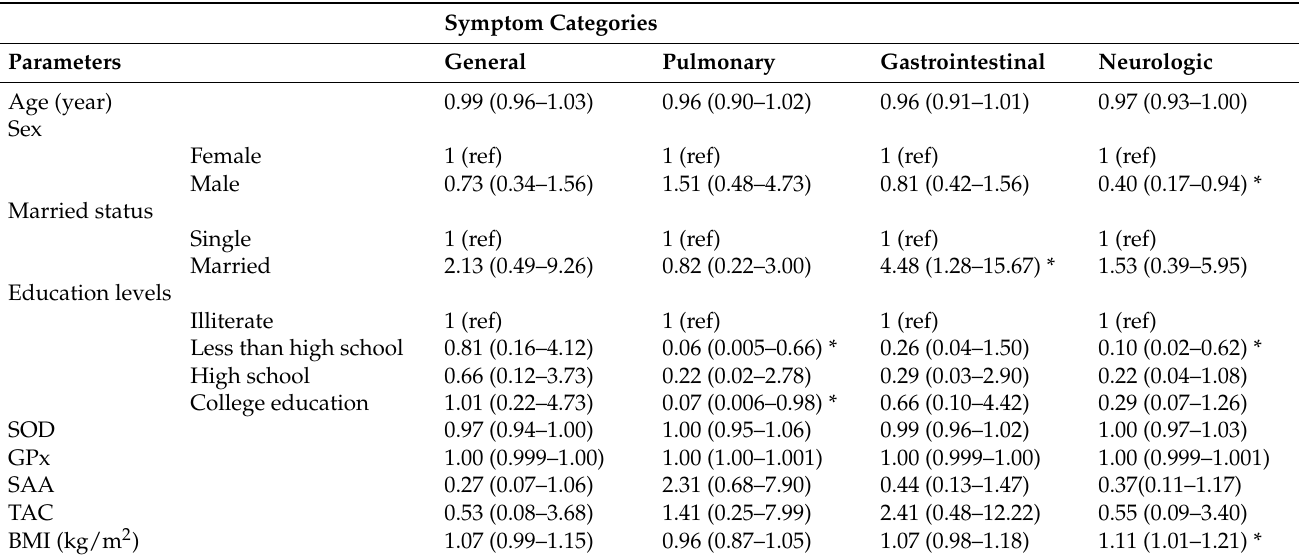
Table 4. Estimates of observed symptom progression of COVID-19 and the association with demo- graphic, BMI, and laboratory parameters among COVID-19 outpatients ( n = 53) †